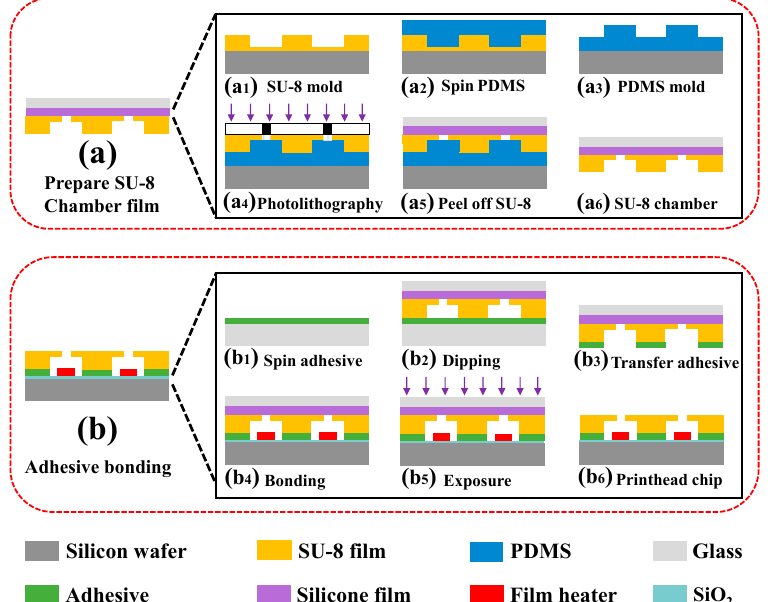
Figure 2. Fabrication schematic of chips for thermal inkjet printheads: ( a ) preparation of SU-8 chamber thin film; ( b ) preparation of printhead chip by adhesive bonding.